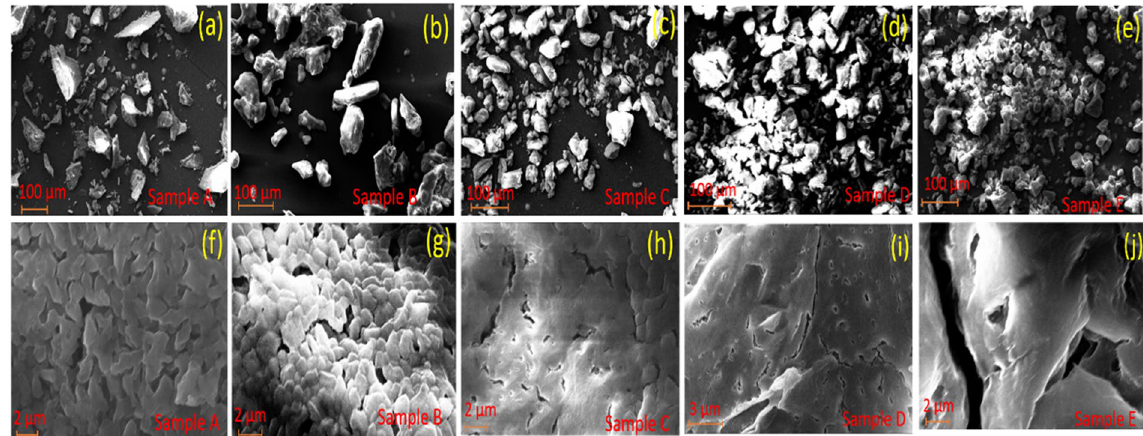
Figure 3. Scanning electron micrographs with 500 X (top panel) and 15000 X (bottom panel) magnifications for sample A, B, C, D and E.